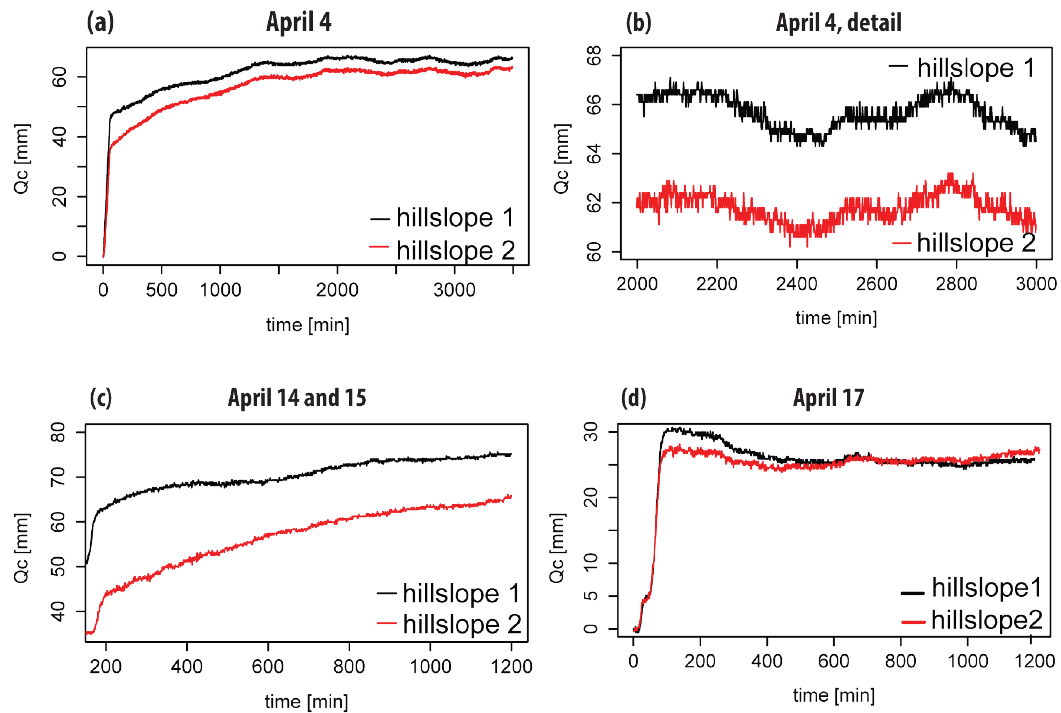
Figure 9. Difference in cumulative drainage (Qc) between hillslope 1 (without macropores) and hillslope 2 (including macropores). ( a ) Qc on 4 April when rainfall intensity was very heterogeneous and the amount of rainfall that both hillslopes received varied as well; ( b ) details of the difference in Qc on 4 April—note the daily variations; ( c ) Qc on 14 April (hillslope 2, including macropores and 15 April (hillslope 1, without macropores). Note that the amount of Qc for hillslope 1 is higher; and ( d ) Qc on 17 April when rainfall intensity was heterogeneous, but there was a small difference between the received amount of rainfall between the two